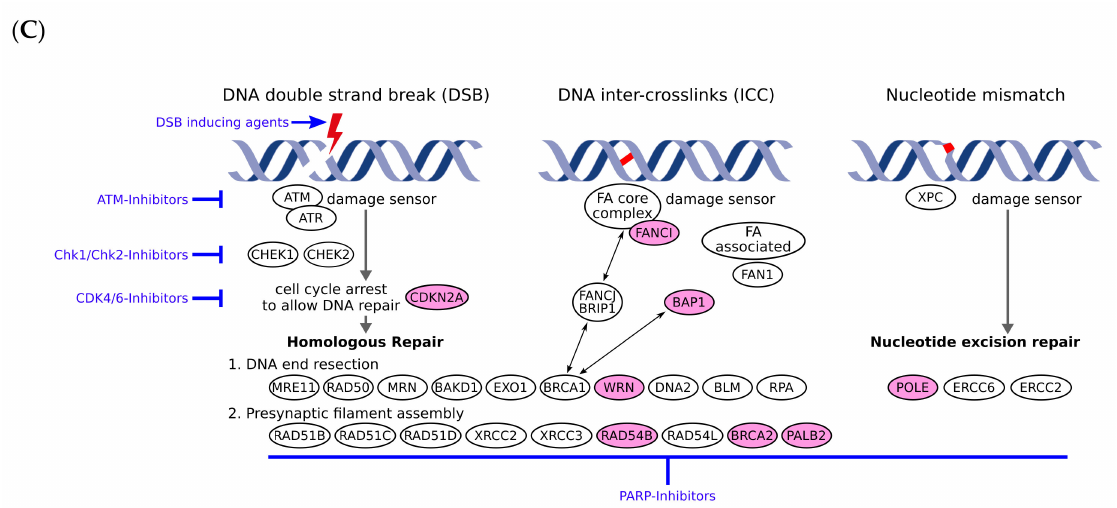
Figure 1. Pathogenic and likely pathogenic germline variants. ( A ) Left pie chart: cohort size by type of detected pathogenic and likely pathogenic (P / LP) germline variants. Each patient is counted according to the most pathogenic variant found (e.g., a patient with a pathogenic variant and a second, likely pathogenic variant is counted in the group of pathogenic variants). Germline variants were found in 15% of patients. Right bar diagram: genes in P / LP germline variants. Most genes harbored mutations in only one patient, while BRCA2 and WRN were a ff ected in two patients each. In one patient two di ff erent genes were a ff ected by germline variants both categorized as likely pathogenic (WRN + POLE). Red bars indicate pathogenic variants, yellow indicates likely pathogenic variants and blue shows a non-classifiable variant according to ACMG. ( B ) Left: STRING protein network of the eight di ff erent genes with pathogenic and likely pathogenic germline variants showing the known interactions of the corresponding gene products. Right: A table with a functional enrichment analysis of the eight genes with pathogenic and likely pathogenic germline variants using the gene ontology (GO) terms “Biological Process”. The first five top ranked (by the false discovery rate FDR) hits are shown. ( C ) Overview of DNA damage repair pathways with genes found a ff ected in our cohort (highlighted in pink) as well as additional highly relevant genes (selection). Blue labels show targets for targeted therapies. Most pathogenic and likely pathogenic germline variants reported in our cohort are in genes associated with DNA damage repair